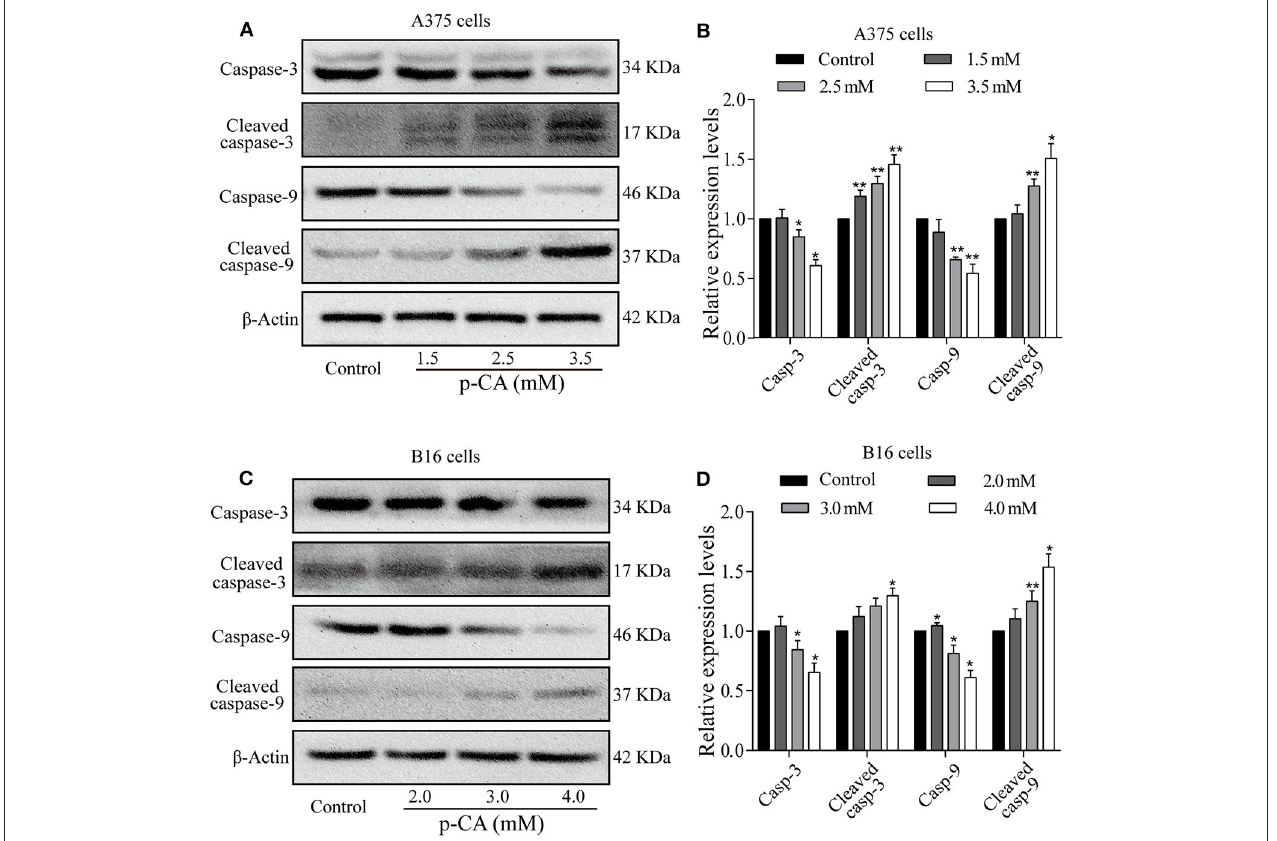
FIGURE 5 | Effects of p- CA on apoptosis-related proteins. (A) The protein levels of caspase-3/9 and cleaved caspase-3/9 in A375 cells treated with p- CA were measured by western blot. (B) The relative protein levels of caspase-3/9 and cleaved caspase-3/9 in A375 cells treated with p- CA were statistically analyzed. (C) The protein levels of caspase-3/9 and cleaved caspase-3/9 in B16 cells treated with p- CA were measured by western blot. (D) The relative protein levels of caspase-3/9 and cleaved caspase-3/9 in B16 cells treated with p- CA were statistically analyzed. The ratio of protein levels is normalized according to the value of the control group. All data are expressed as the mean ± SD of three independent experiments. * P < 0.05, ** P < 0.01 compared with the